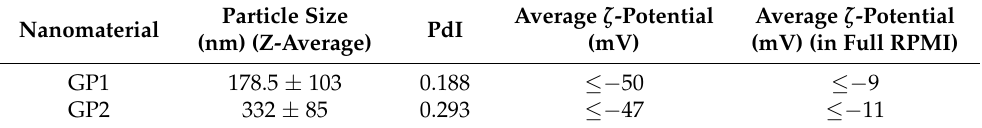
Table 1. Physical properties of GP